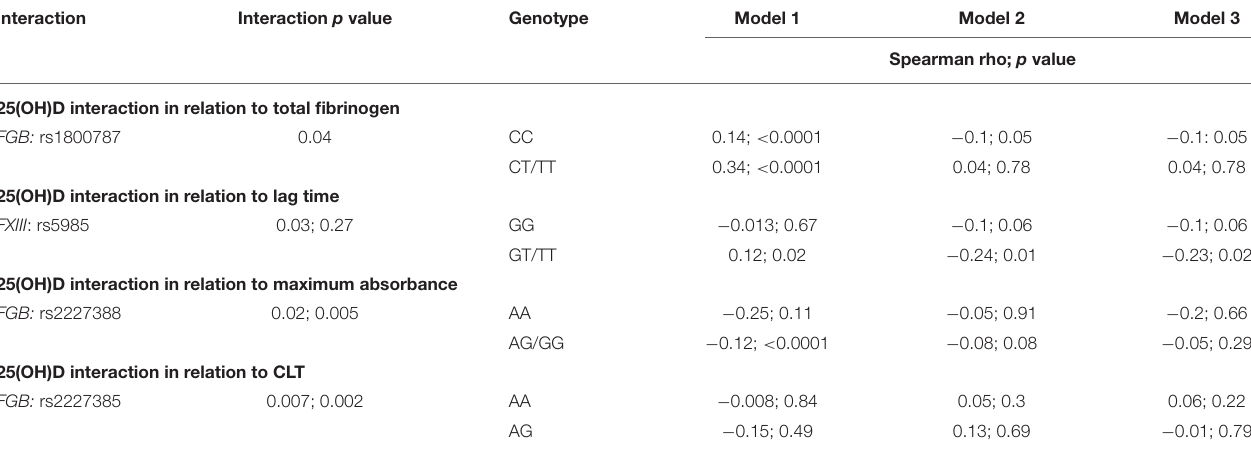
TABLE 4 | FGB and FXIII gene polymorphisms’ interactions with 25(OH)D in relation to plasma fibrin clot properties.